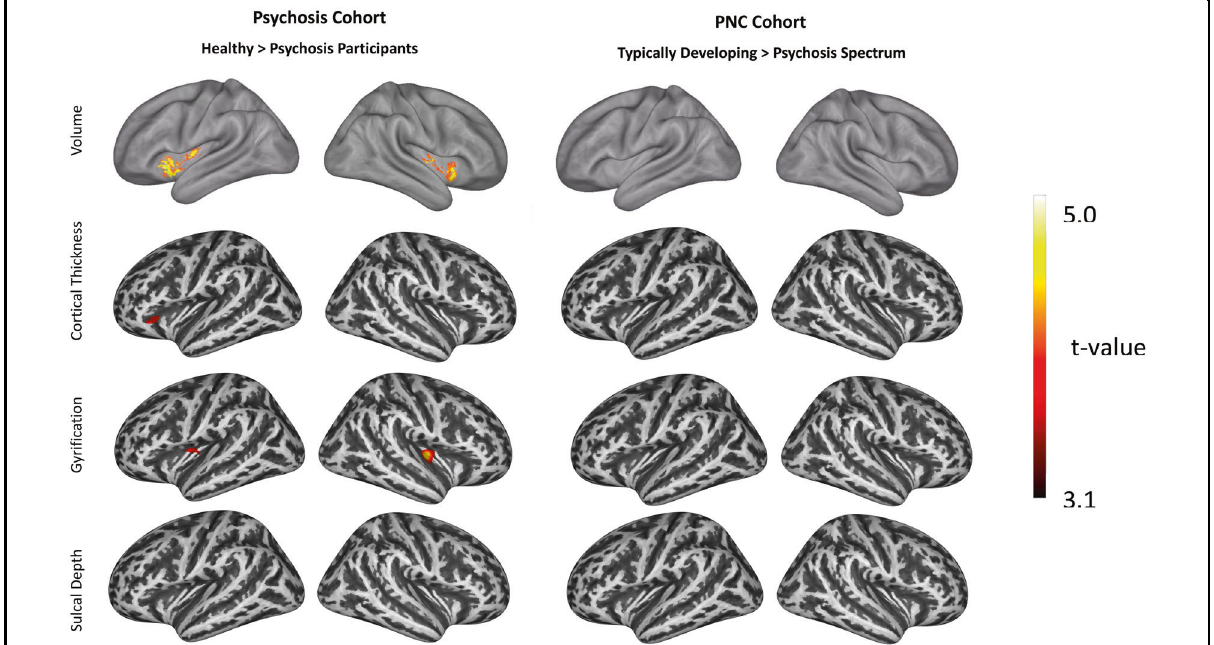
Fig. 2 Insula volume and surface-features based on voxel-wise and vertex-based analyses. To complement our region-of-interest analyses, we conducted voxel-wise (volume) and vertex-based (surface) analyses of insula structure in each cohort using explicit insula masks 64,66 . Group differences within the psychosis (healthy controls > psychosis) and PNC (typically developing > psychosis spectrum youth) cohorts are displayed. Mirroring and extending our region-of-interest analyses, psychotic disorder participants had reduced volume and gyri fi cation and well as reduced cortical thickness. No signi fi cant group differences were observed in the PNC. Cluster-level corrected p FWE = 0.05 for voxel-wise p < 0.001 uncorrected, controlling for age, gender, total intracranial volume (TIV), study (for psychotic disorders cohort), and topography defects (for surface- based